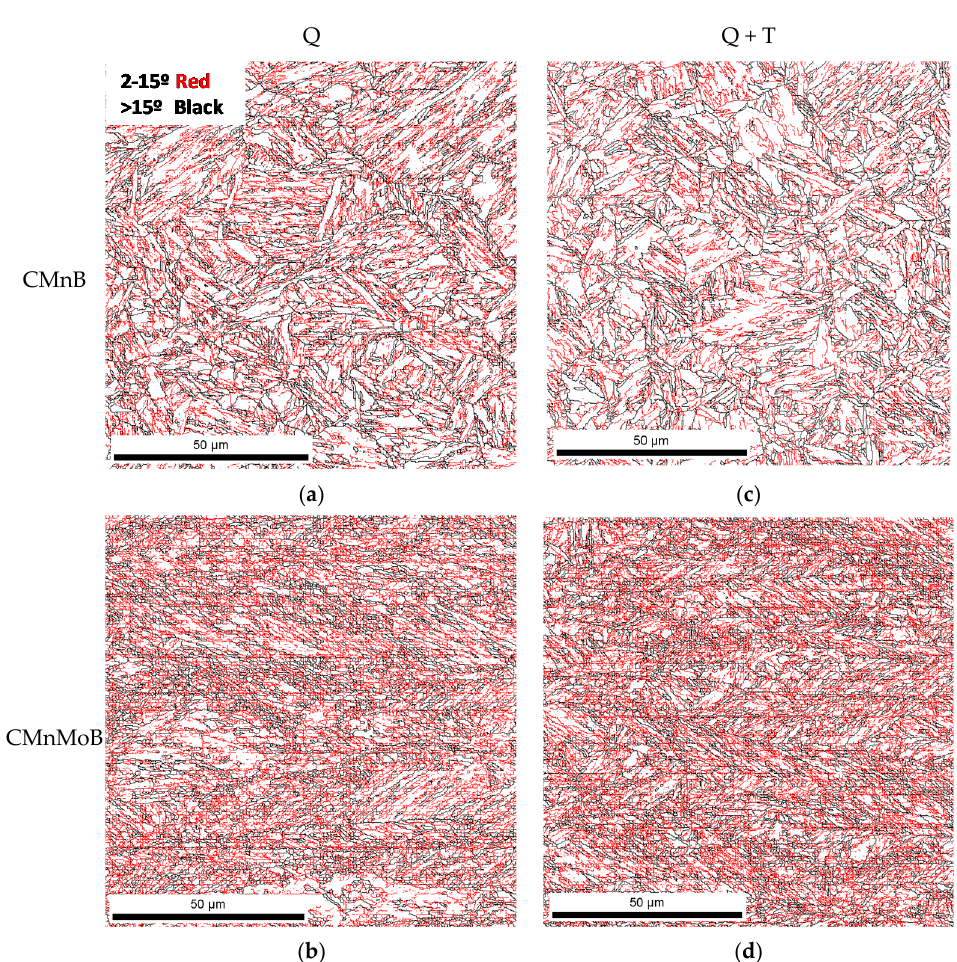
Figure 5. Influence of tempering on the Grain Boundary maps related to ( a , c ) CMnB and ( b , d ) CMnMoB.